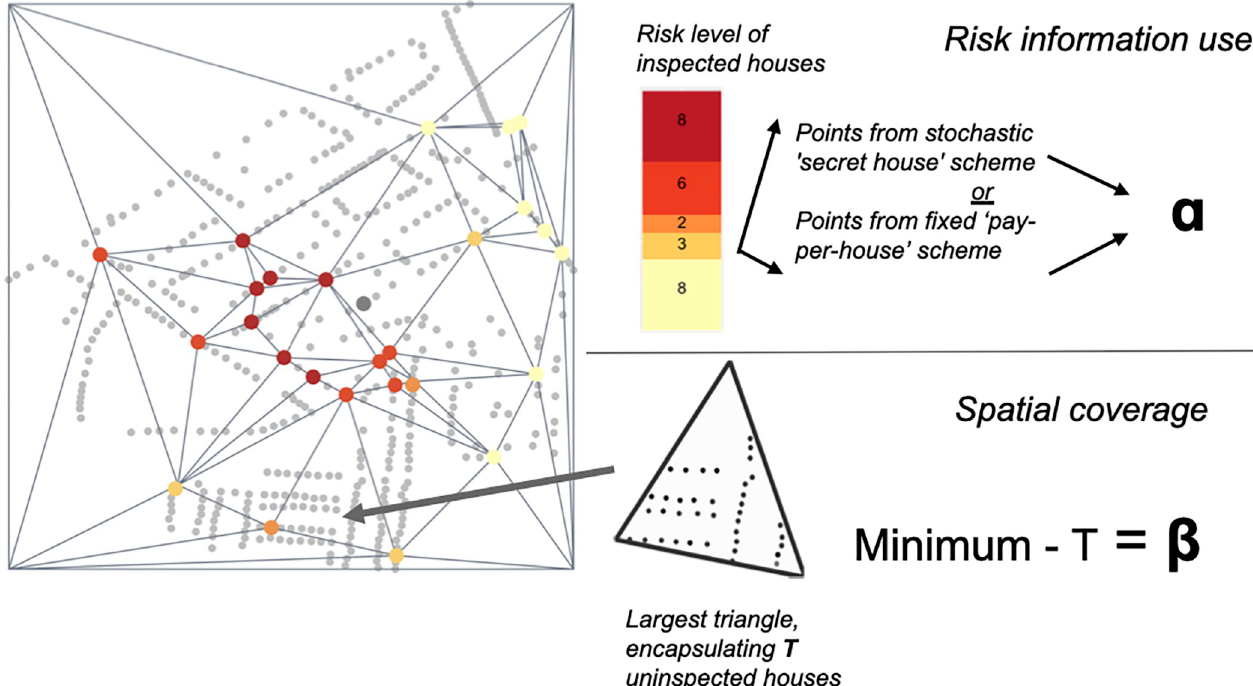
Fig 2. Representation of risk-based and spatial incentives. Left: Map displaying a search area of N households, each represented by a dot that is colored one of five colors representing relative risk of vector infestation. Top right: ‘ α ’ represents the reward for risk information use, which was earned in a stochastic or fixed incentive scheme. Bottom right: β represents the reward for spatial coverage, which is calculated by subtracting the maximum number of uninspected houses bounded by Delaunay triangles formed between the inspected houses, T, from the minimum expected coverage (N � .05). In the first three trials, the total reward was a weighted average of α and β . In the final trial, values of α and β were added together to form hierarchical ’poker hands’.